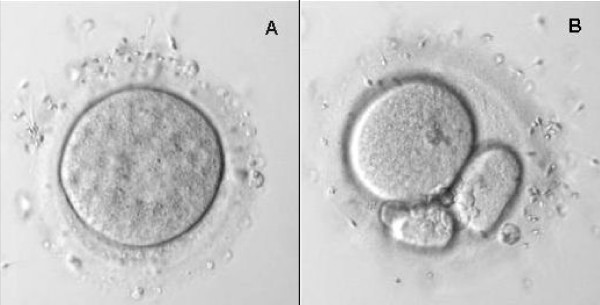
Sperm binding test using unfertilised and fertilised human oocytes. Unfertilised human oocytes recovered after IVF failure (A) and fertilised oocytes with a high fragmentation rate two days after fertilisation (B), were cleared of bound spermatozoa and re-inseminated. After three hours, oocytes were similarly washed by repeated aspiration in a pipette, and the number of spermatozoa bound to the surface was determined under a microscope. Original magnification ×400.